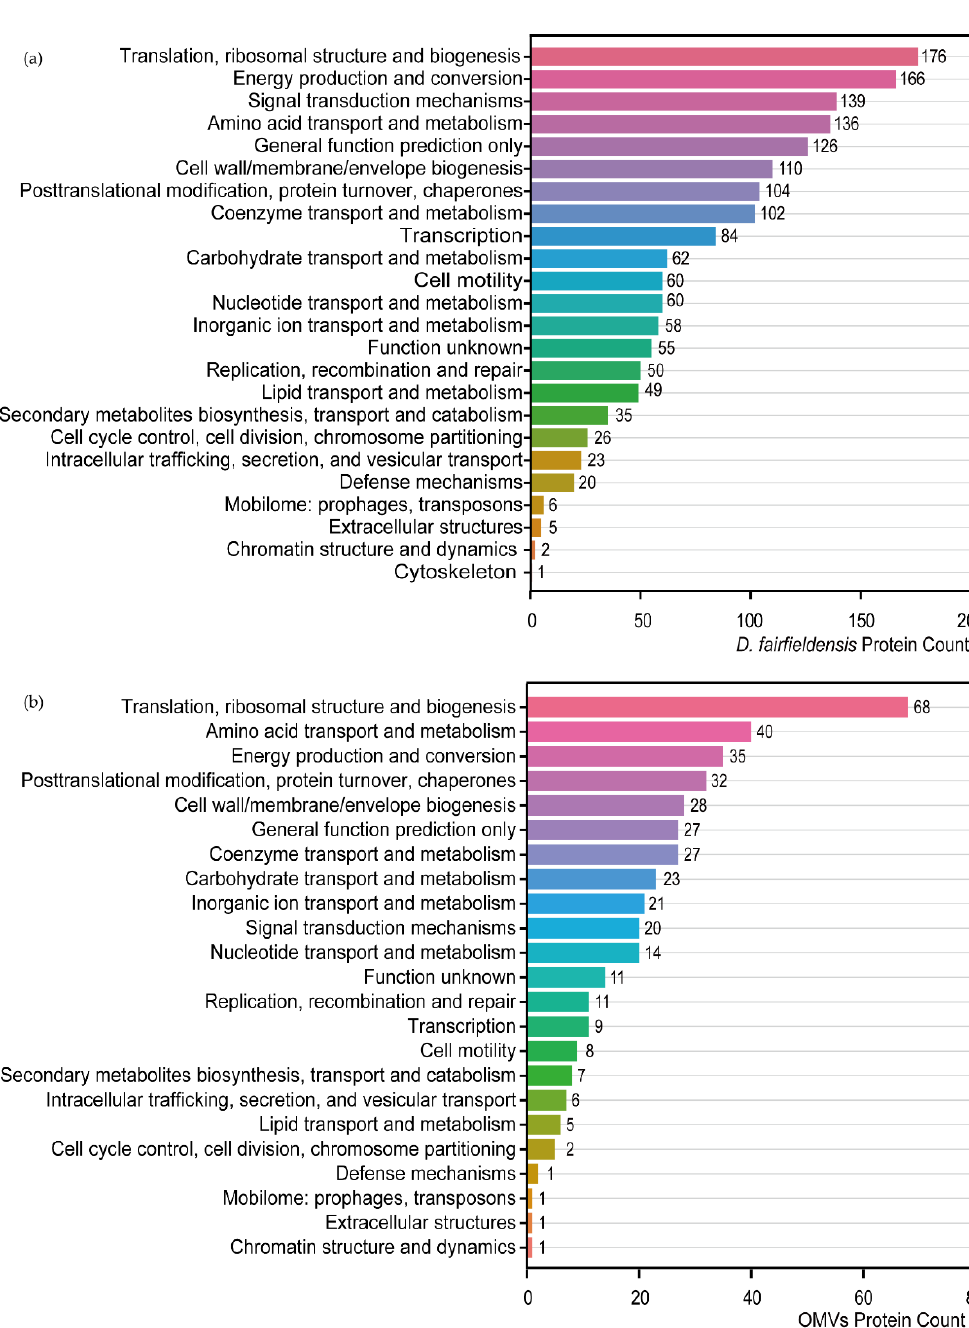
Figure 3. Protein function prediction of D. fairfieldensis ( a ) and its secreted OMVs ( b ) against COG database.